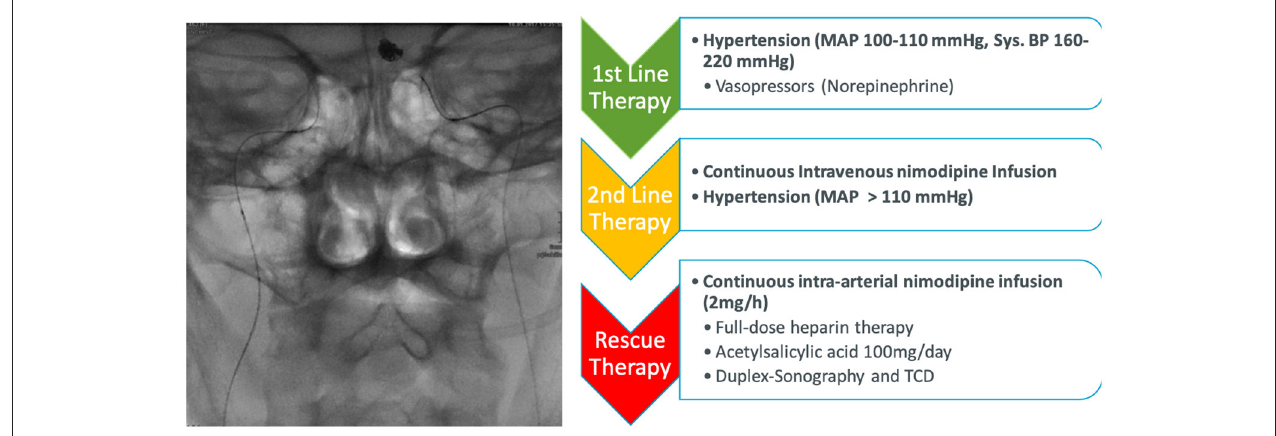
FIGURE 1 | Treatment pathway of delayed cerebral ischemia and cerebral vasospasm. All patients received 60mg nimodipine orally every 4h after admission. In the case of progression cerebral vasospasm (CV) and delayed cerebral ischemia (DCI) the nimodipine was switched to intravenous application and strict induced hypertension was started. In the case of further therapy-refractory CV and DCI resulting in perfusion deficit and/or severe neurological impairment continuous intra-arterial nimodipine therapy was